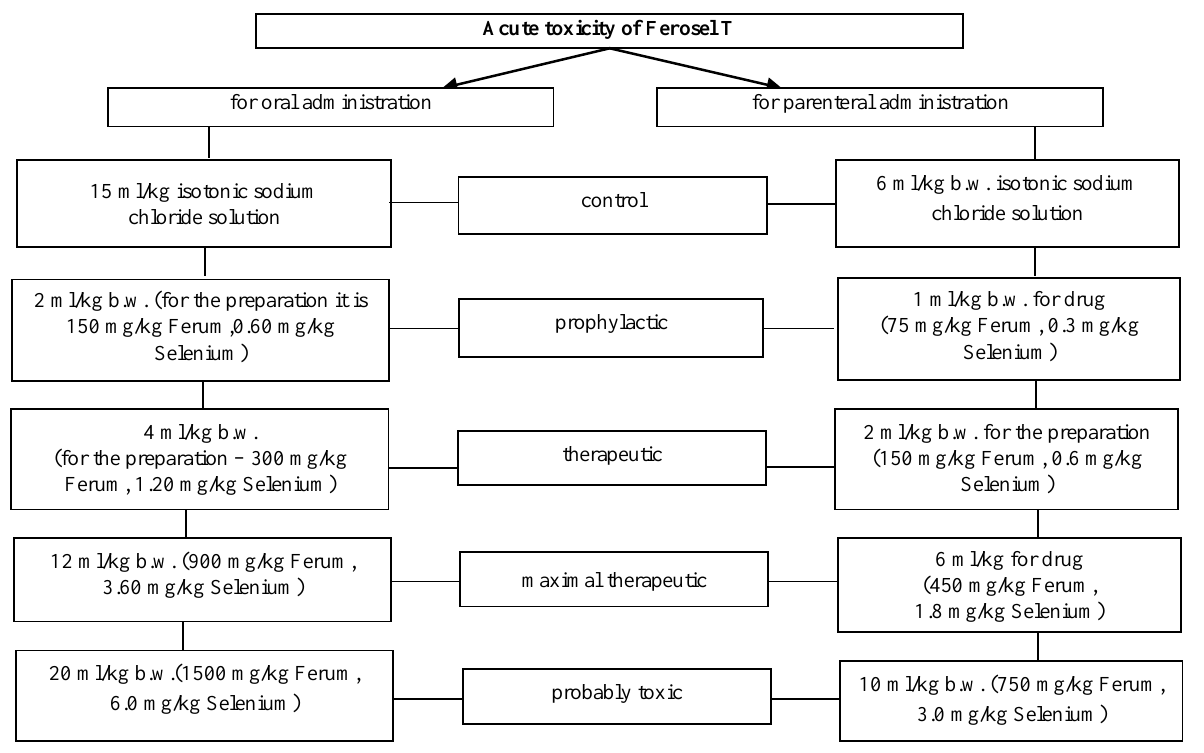
Fig. 1. The research to determine the acute toxicity